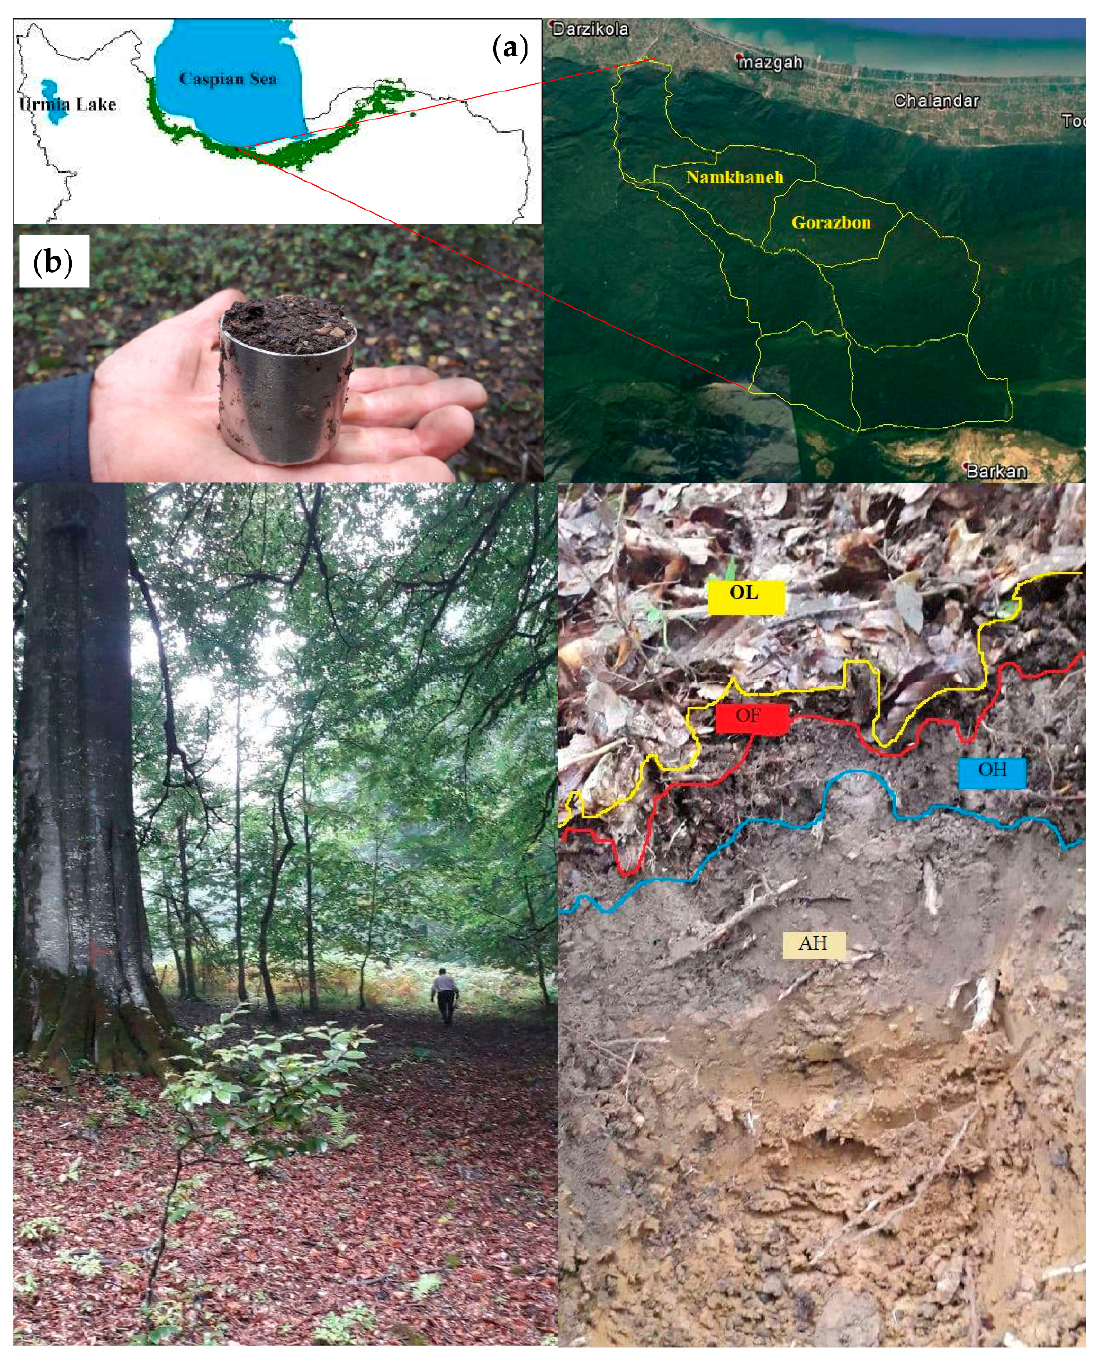
Figure 1. Study area (Namkhaneh and Gorazbon districts of Kheyrud forest) in northern Iran ( a ), Skid trails in each of the forest stands, soil profile and soil samples with metal cylinder ( b ).